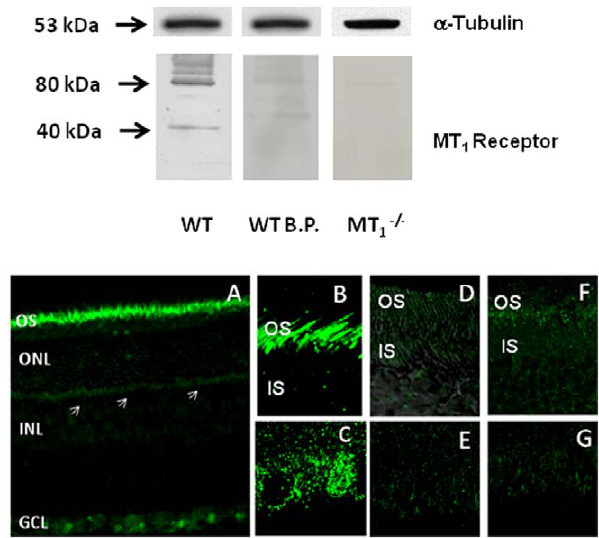
Figure 1. MT 1 receptor immunoreactivity in the mouse retina. A band corresponding to the molecular weight of approximately 40 kDa was observed in western blotting of retinal extract from WT mice. No band was observed when the blot was treated with antibody pre- absorbed with the blocking peptide. A band of approximately 80 kDa was also present in retinal extract from WT mice. A very faint band around 80 kDa was also present the blot treated with the blocking peptide and in the blot of retinal extract from MT 1 2 / 2 mice. a -Tubulin expression at the molecular weight of 53 kDa is also shown. Ab=Melatonin receptor 1 antibody; BP=blocking peptide. Similar results have been obtained for at least 3 independent samples for each experimental condition (Top panel). MT 1 immunoreactivity was localized in the outer segments of the photoreceptors (A, B), and in the ganglion cells (A, C), while a weak signal is observed in the outer plexiform layer (A, white arrows). No signal was detected in the outer segments or in ganglion cells using the blocking peptide (D, E) or in retina obtained from MT 1 2 / 2 mice (F, G). OS=outer segments; IS=inner segments; ONL=outer nuclear layer; INL=inner nuclear layer; GCL =ganglion cell layer. Micrographs are representative of results obtained from at least four animals for each experimental condition (Bottom panel).